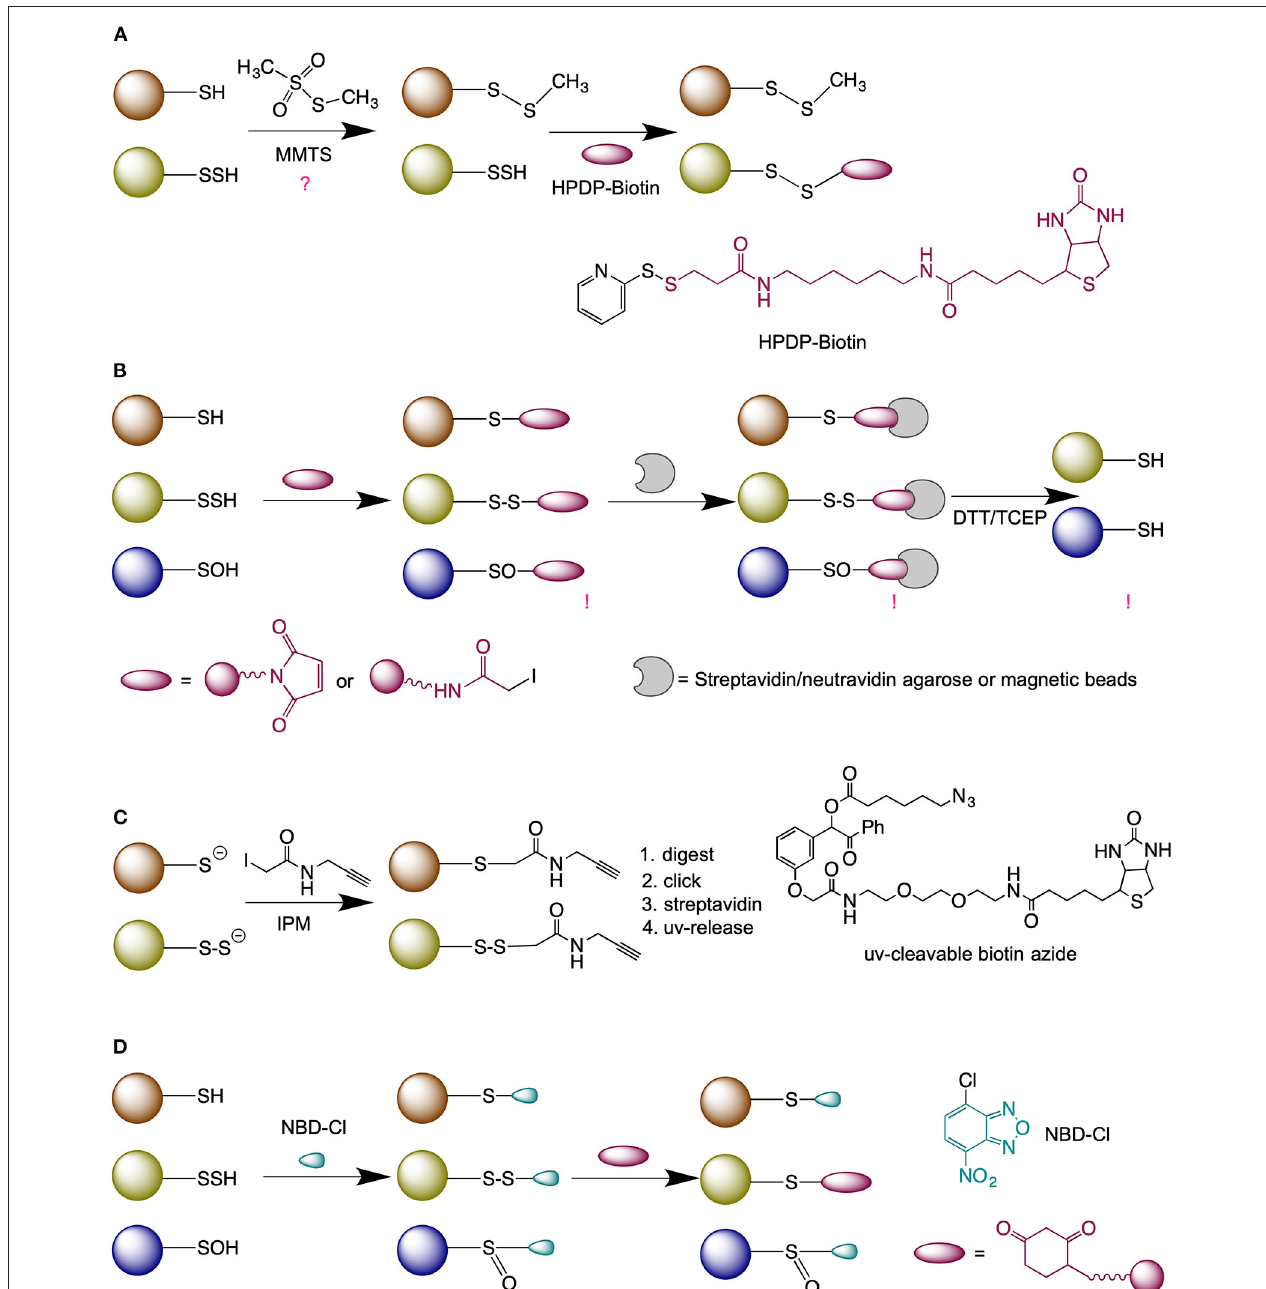
FIGURE 2 | Methods for persulfide labeling. (A) Modified-biotin switch assay. (B) Method based on thiol blocking (either with N-ethyl maleimide or iodoacetmide) followed by the reduction with dithiothreitol (DTT) or tris(2-carboxyethyl)phosphine (TCEP). (C) Low-pH quantitative thiol reactivity profiling approach. (D) Dimedone-switch method for persulfide labeling. NBD-Cl, 4-Chloro-7-nitrobenzofurazan.